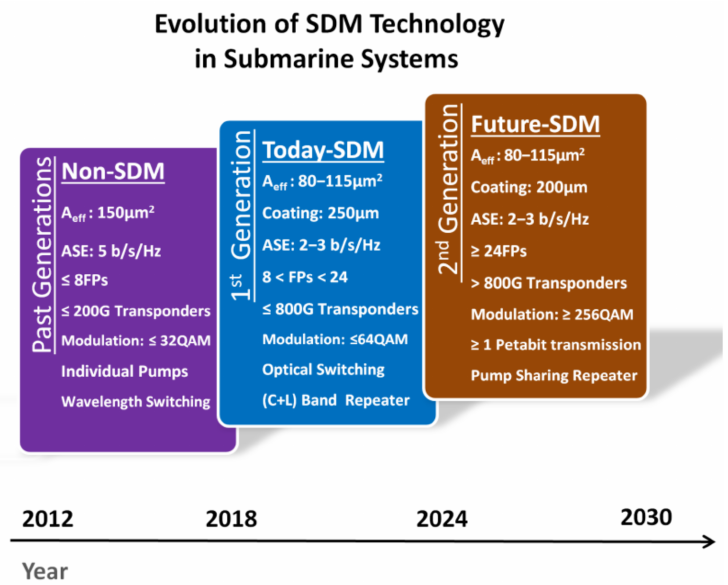
Figure 36. Evolution of submarine system’s technology.